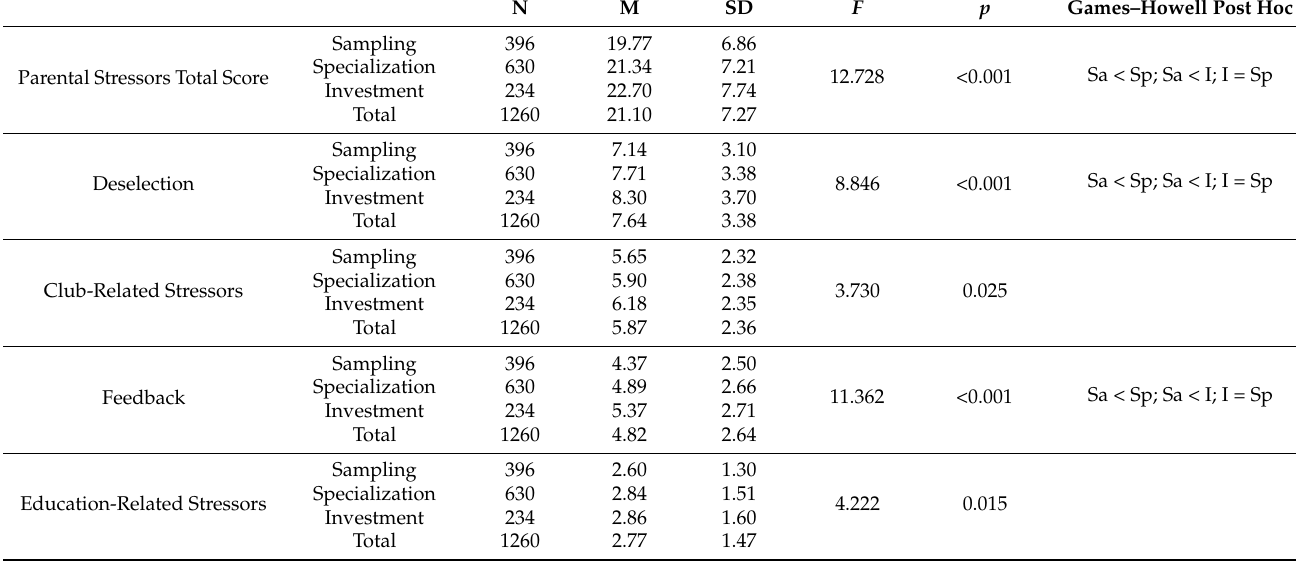
Table 2. Differences in parental stress by children’s sport participation stage. N M SD F